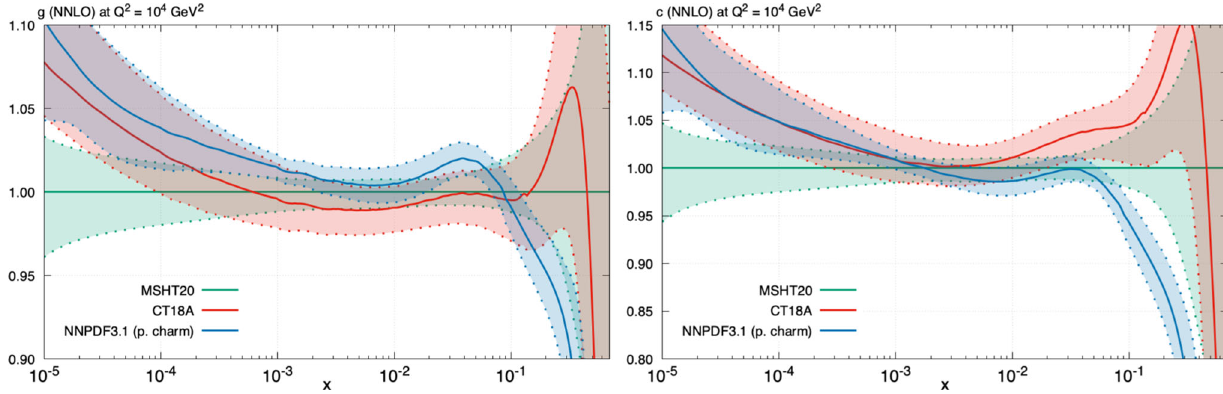
Fig. 96 As in Figs. 89 (left) and 95 (right), but with the NNPDF3.1 set corresponding to perturbative charm shown x the NNPDF charm PDF lies below CT18 and